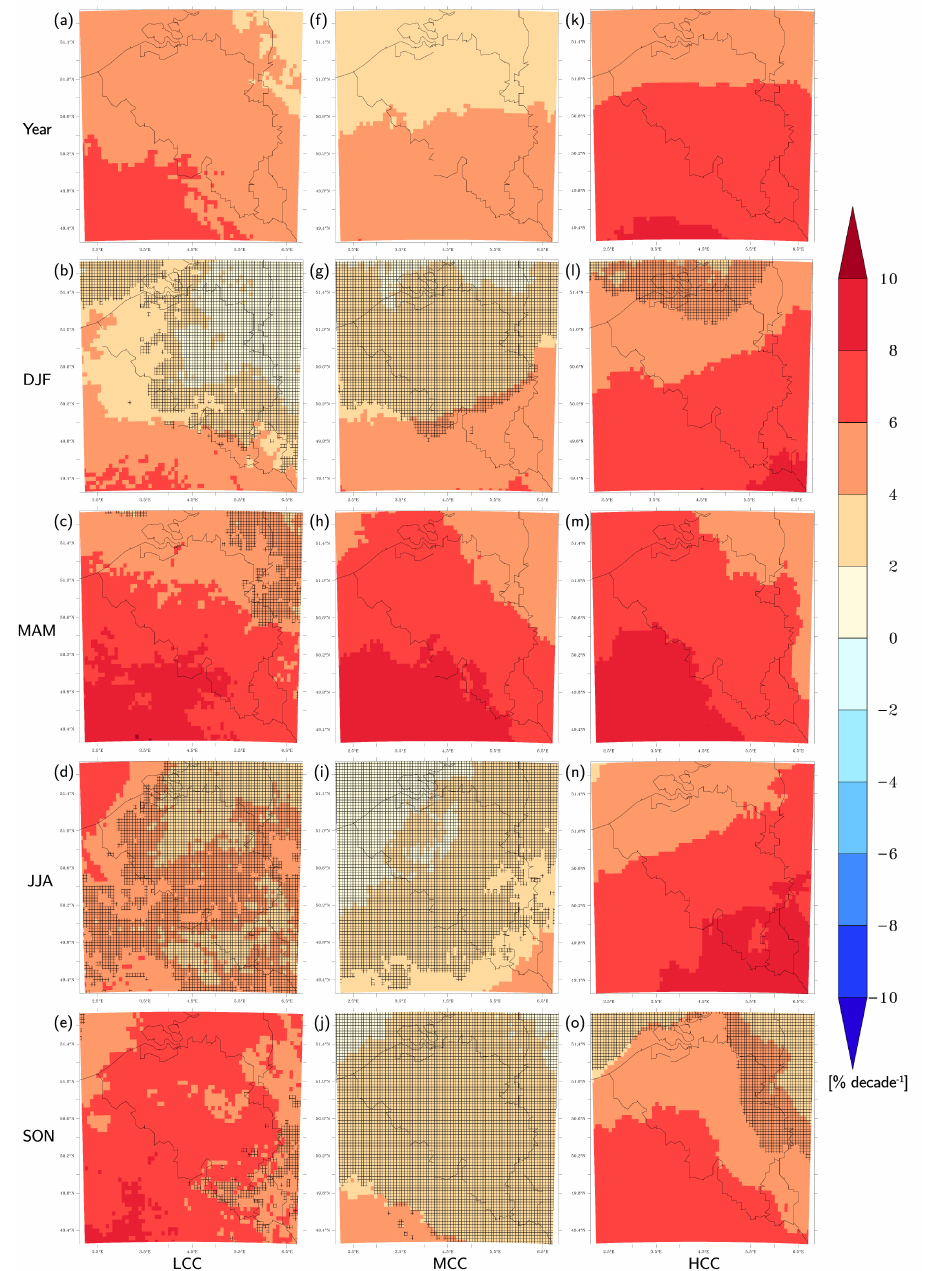
Figure 7. Annual and seasonal trends in ( a – e ) low cloud cover (LCC), ( f – j ) medium cloud cover (MCC), and ( k – o ) high cloud cover (HCC) computed from the MAR-ERA outputs for 1959–1979 (dimming period). Filled pixels indicate the places where the trends are statistically significant at the 95% confidence level. Hashed pixels indicate the places where the trends are statistically